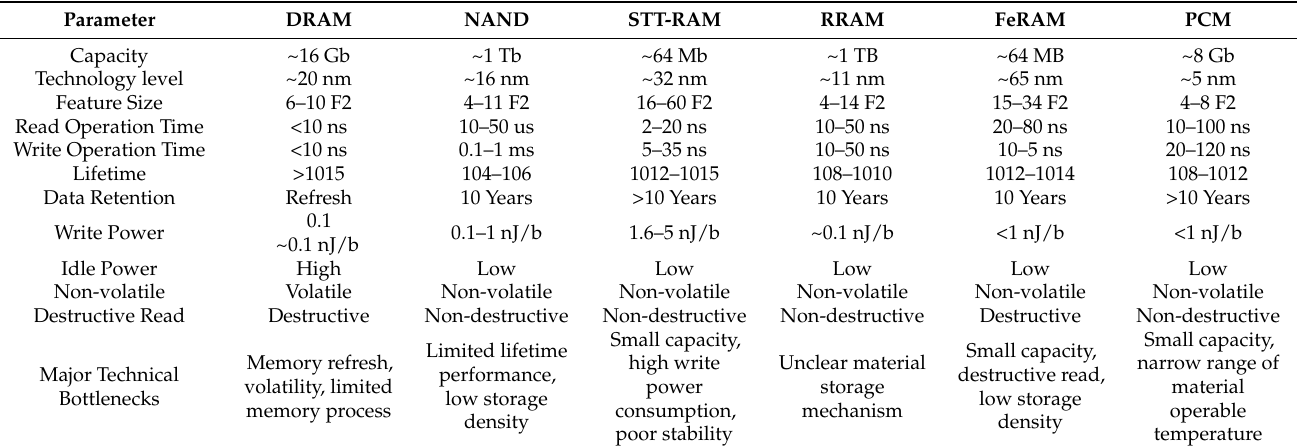
Table 3. Comparative information of different memory